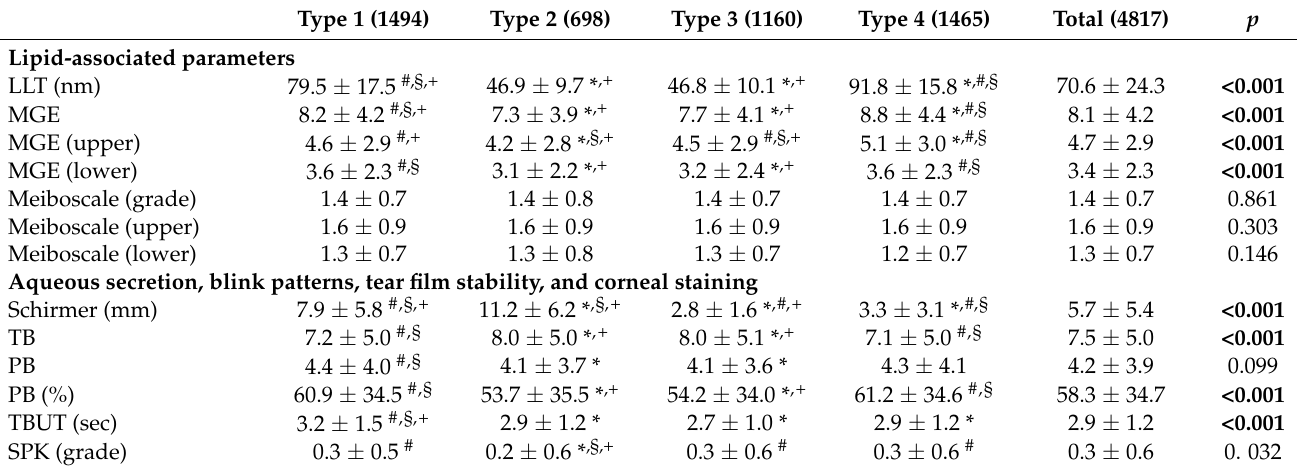
Table 3. Summary of objective dry eye